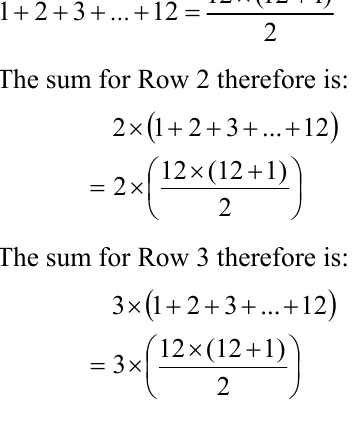
inspection, i.e. by just “looking” (Olivier, 1999, p. 2). By “filling in the gaps” such as writing  21 1 and  21